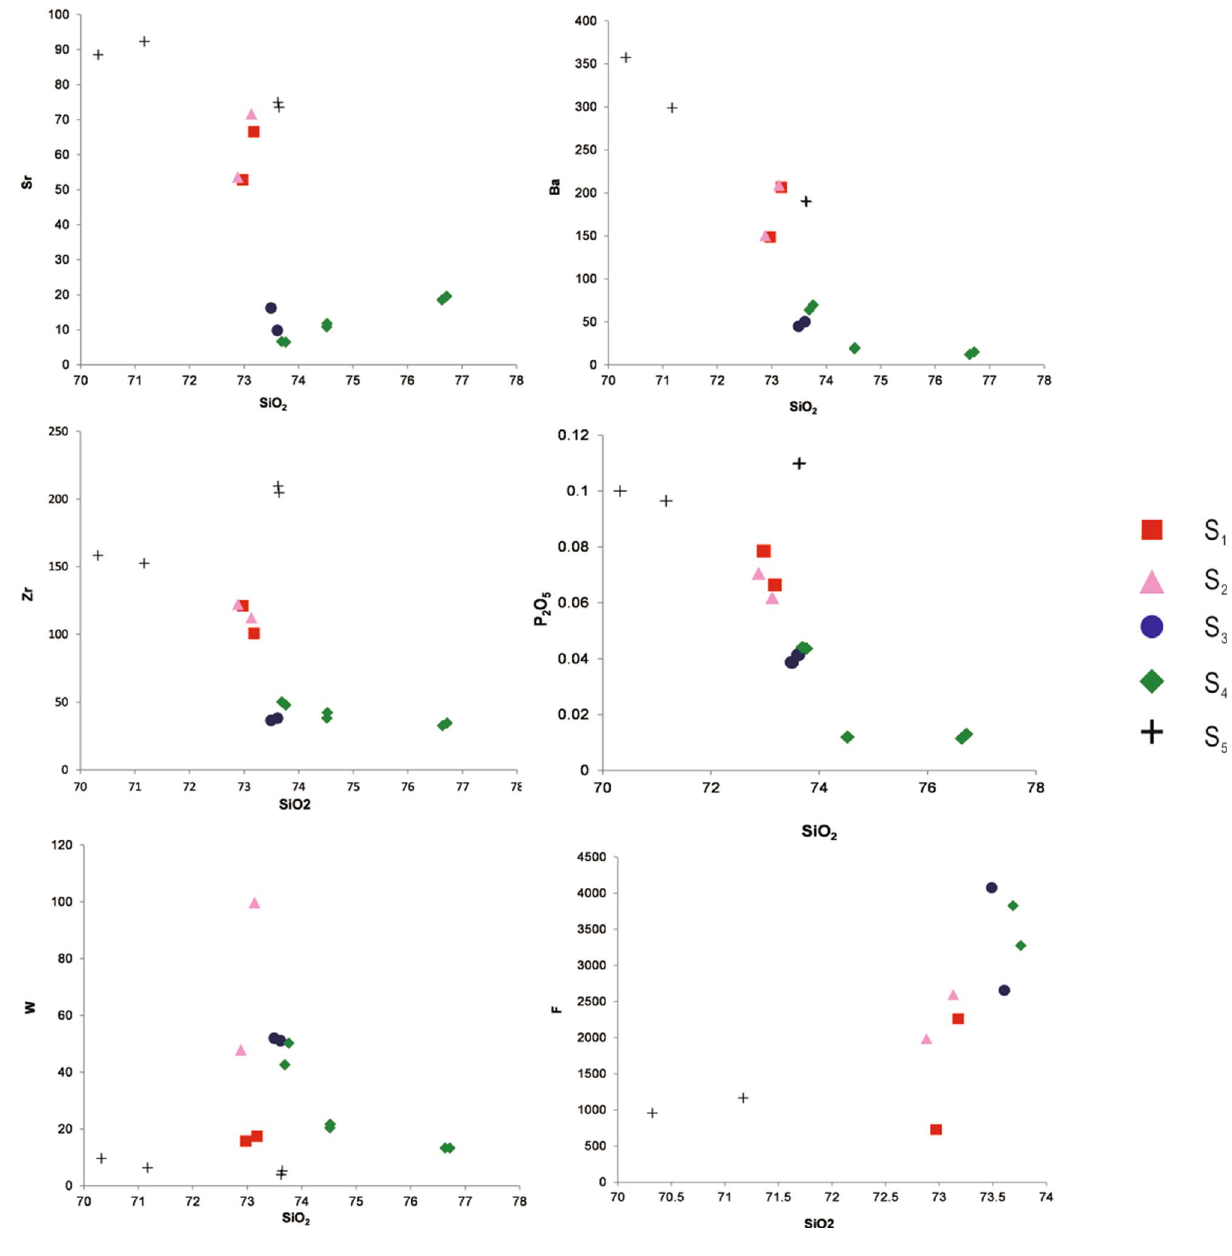
Figure 8. SiO 2 vs Sr, Ba, Zr, P 2 O 5 , W and F for the geochronological Ar–Ar dating on a fluid inclusion in quartz and coexisting muscovite 30 . This age also agrees with our dates. In conclusion, the QGC has two impacts on the Shizhuyuan deposit. (1) Heat supply: According to the thermal model of Mclaren et al. (1999) 5 , the heat derived from the high-heat-producing granites reaches a maxi- mum ~ 10 Myr after its emplacement. Furthermore, the thermal disturbances caused by the high-heat-producing granites can drive hydrothermal fluid convection, resulting in mineralization. For instance, the mineralization in the Mount Elliott Cu-Au deposits, Australia, was produced by hydrothermal convection driven by the heat released from its associated high-heat-producing granite. The volume heat of the QGC estimated by the U, Th, and K contents is 5.89–14.30 μWm −3 (volume heat of high-heat-producing granite > 5 μWm −3 ), indicating their high heat production. Therefore, when mineralization occurred, the heat anomaly resulting from the QGC was quite strong (nearly its maximum strength), which promoted the development of hydrothermal convection around the QGC, leading to the generation of the Shizhuyuan deposit. (2) Metal supply: Field observations reveal that the Shizhuyuan W–Sn–Mo–Bi deposit is located at the endo-contact of the skarn and the porphyritic biotite granite (S 1 , S 2 ) and equigranular granite (S 3 , S 4 ), demonstrating their close spatial relationship 21,37 . In addition, as shown in Fig. 8a, the W contents in the S 1 , S 2 , S 3, and S 4 granites are mostly 40–60 ppm; therefore, the QGC can supply sufficient metal for mineralization.